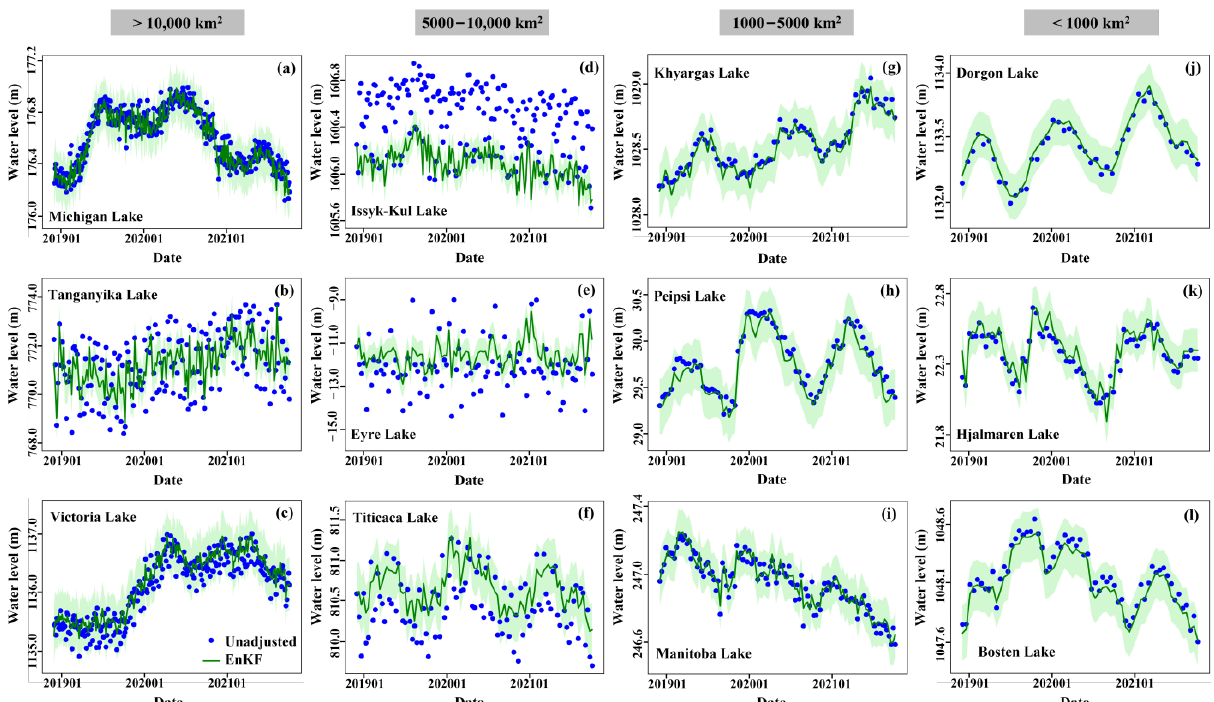
Figure 4. Optimized water level time series of selected lakes derived from multi-orbit ICESat-2 footprints over ( a ) Michigan Lake, ( b ) Tanganyika Lake, ( c ) Victoria Lake, ( d ) Issyk-Kul Lake, ( e ) Eyre Lake, ( f ) Titicaca Lake, ( g ) Khyargas Lake, ( h ) Peipsi Lake, ( i ) Manitoba Lake, ( j ) Dorgon Lake, ( k ) Hjalmaren Lake, and ( l ) Bosten Lake. Blue points represent unadjusted water level time series directly derived from the multi-orbit ICESat-2 observations. The green line represents the time series of lake water levels optimized by multi-orbit adjustment and filtering (EnKF results). The light green range represents the uncertainty of the optimized water level time series.